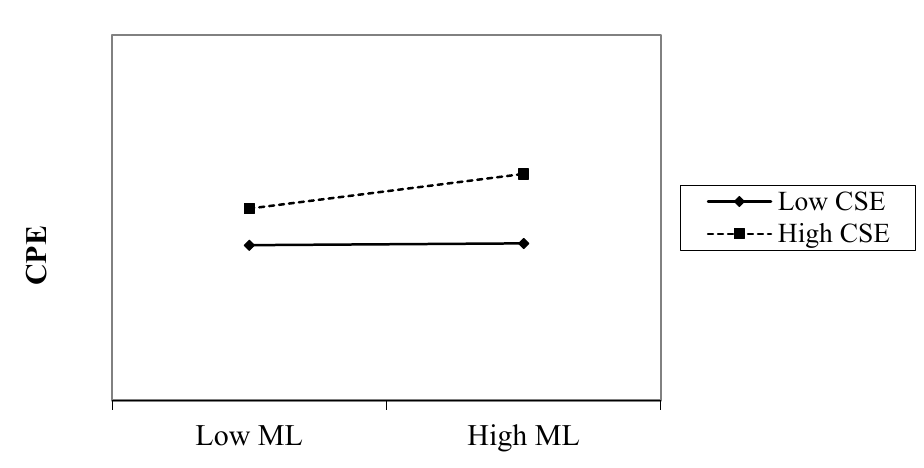
Figure 2. The interaction effect of CSE on the relationship between ML and CPE.